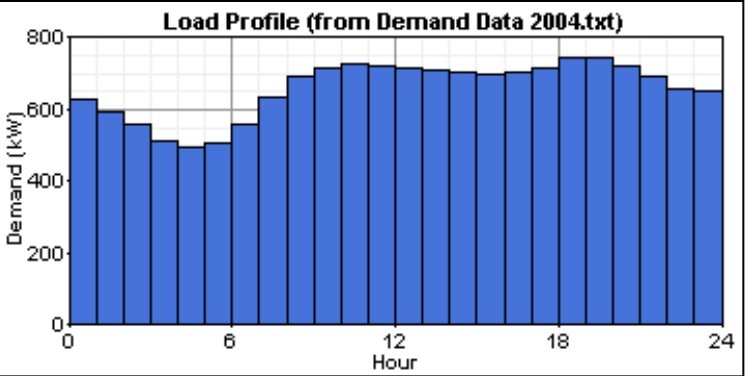
Figure 2. HOMER load data (average daily profile) used in